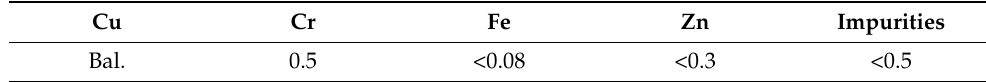
Table 1. Chemical composition of the initial powder, mass